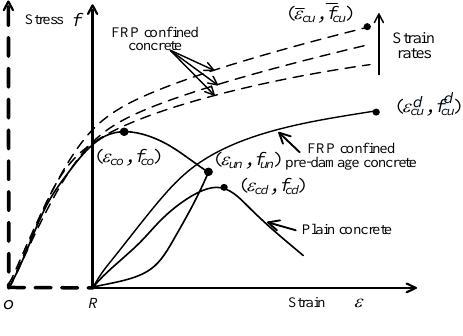
Figure 2. Typical stress–strain curves.